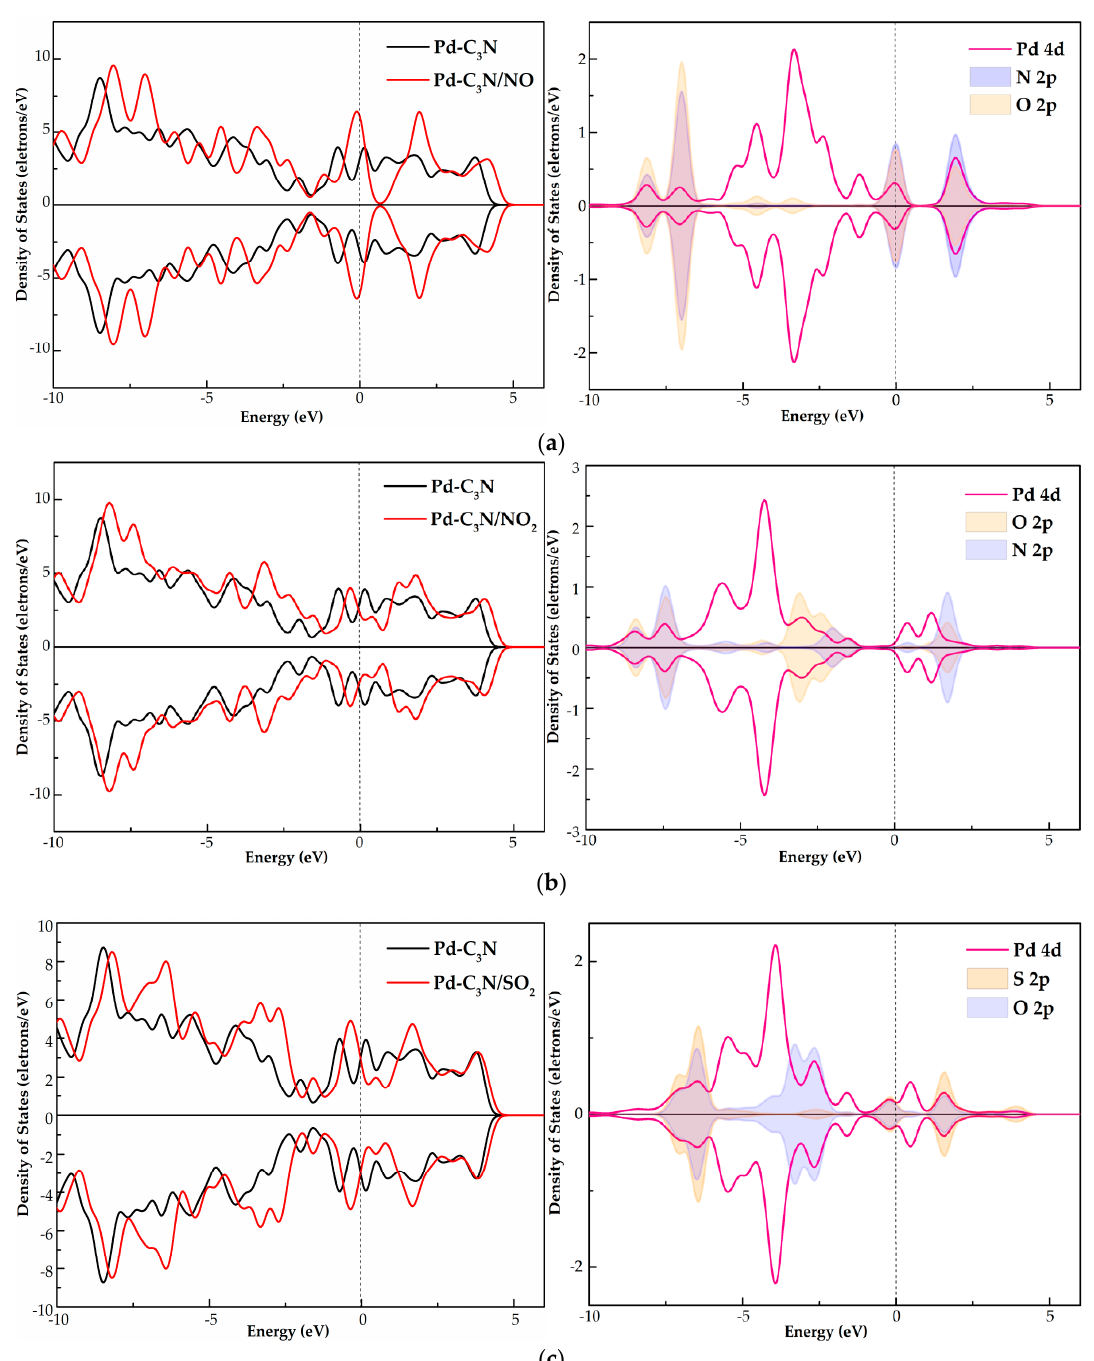
Figure 5. TDOS and PDOS of ( a ) NO, ( b ) NO 2 and ( c ) SO 2 adsorption systems, the dotted line indicates the Fermi energy.